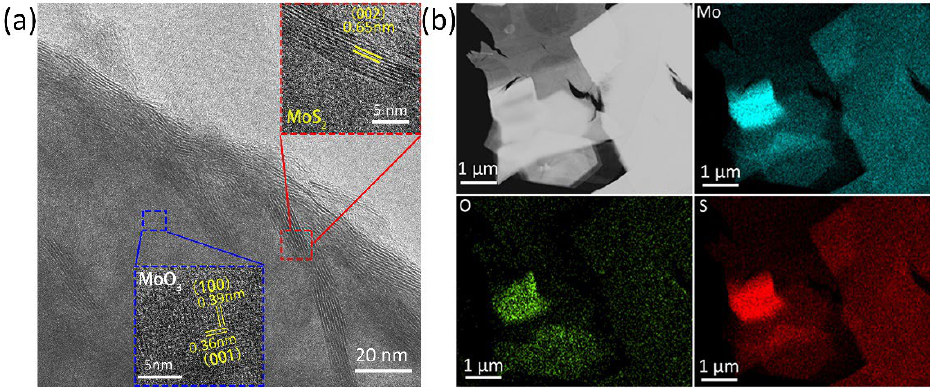
Figure 3. ( a ) TEM image and ( b ) EDS element mapping of the sulfurized MoO 3 nanoribbons. Raman spectra were also collected to further understand the structural change of MoO 3 by sulfurization. As shown in Figure 4a, the Raman spectrum for as-grown MoO 3 (black line) exhibits the expected Raman modes for α -MoO 3 with a layered structure [47,48]. In particular, it has well-defined Raman features associated with the vibration modes of the oxygen atoms terminating the van der Waals layer at 996 cm − 1 (M = O asymmetrical stretching), as well as the stretching mode of the O-Mo bonds at 818 cm − 1 for the corner-shared oxygen and at 666 cm − 1 for the edge-shared, triply bonded oxygen [49,50]. After sulfurization, the Raman spectrum (red line) displays new peaks in addition to retaining the majority of the characteristic features of MoO 3 . Most notably, the new peaks at 381 cm − 1 and 406 cm − 1 are consistent with the characteristic in-plane E 1 vibration mode and the 2 g out-of-plane A 1 g vibration mode of 2H-MoS 2 , respectively [46,51]. The two Raman peaks have a frequency difference of ~25 cm − 1 , suggesting that the MoS 2 on the surface of MoO 3 is multilayer, which is consistent with the HRTEM results. Moreover, the peak 454 cm − 1 is assigned to the second order 2LA(M) phonons of MoS 2 which are generally present in multilayers of MoS 2 [52,53]. There are, however, additional Raman peaks that cannot be exclusively assigned to MoO 3 or MoS 2 , such as strong Raman features at 198, 222, 560, and 730 cm − 1 , and they are best assigned to the vibration modes of Mo-O and Mo-S bonds in intermediate compound molybdenum oxysulfide (MoO 3 − x S y ) as a result of incomplete sulfurization described in the reaction in Equation (2) [40]. The co-existence of MoO 3 , MoS 2 , and the intermediate molybdenum oxysulfide is further corroborated by XRD. Figure 4b shows the XRD patterns of MoO 3 before (black line) and after (red line) sulfurization. The intense diffraction peaks of pristine MoO 3 can all be indexed to the orthorhombic α -MoO 3 (JCPDS Card No. 00-005-0508) including the (0 2 0) and (0 4 0) planes that are characteristic for layered MoO 3 [27,54,55]. After sulfurization, the XRD patterns display several additional diffraction peaks including the diffraction peaks with 2 θ at 14.4 ◦ , 39.5 ◦ , and 44.3 ◦ corresponding to reflections of the (002), (103), and (006) planes of 2H-MoS 2 (JCPDS No. 00-037-1492) [44,56], confirming again the formation of MoS 2 on the MoO 3 nanoribbons after sulfurization. With the 2 θ position of the (002) diffraction peak and the wavelength of Cu K α line ( λ = 0.15418 nm), we can arrive at an interlayer distance of 0.62 nm for MoS 2, in good agreement with the d-spacing determined by HRTEM in Figure 3a. The formation of intermediate MoO 3 − x S y is also supported by the appearance of additional XRD patterns consistent with those from a representative molybdenum oxysulfide MoS 0.12 O 1.88 (JCPDS No. 04-007-8381).